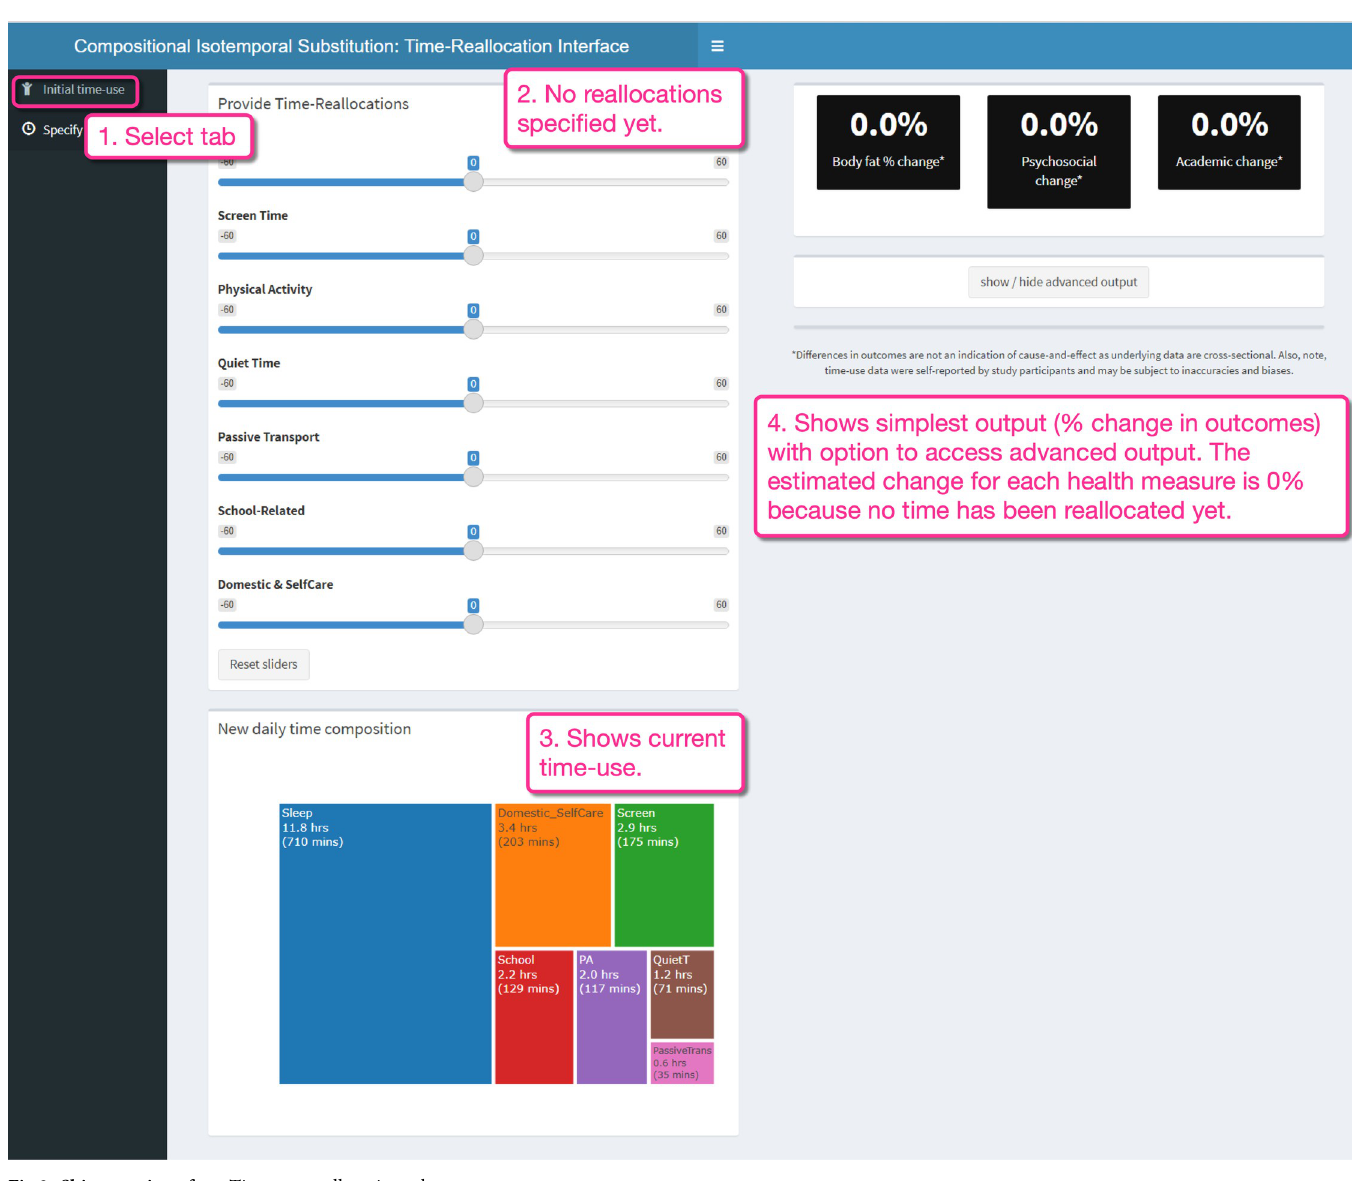
Fig 2. Shiny app interface. Time-use reallocation